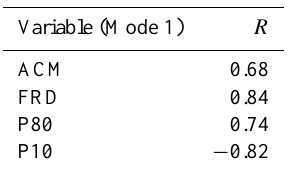
Table 1. Correlation among the first mode of all predictor vari- ables (X modes, red lines in Fig. 6) and normalized differences be- tween Ni˜no3 and AMO. All values have a statistical significance above 99% ( α < 0.01). Significance was calculated according to Davis